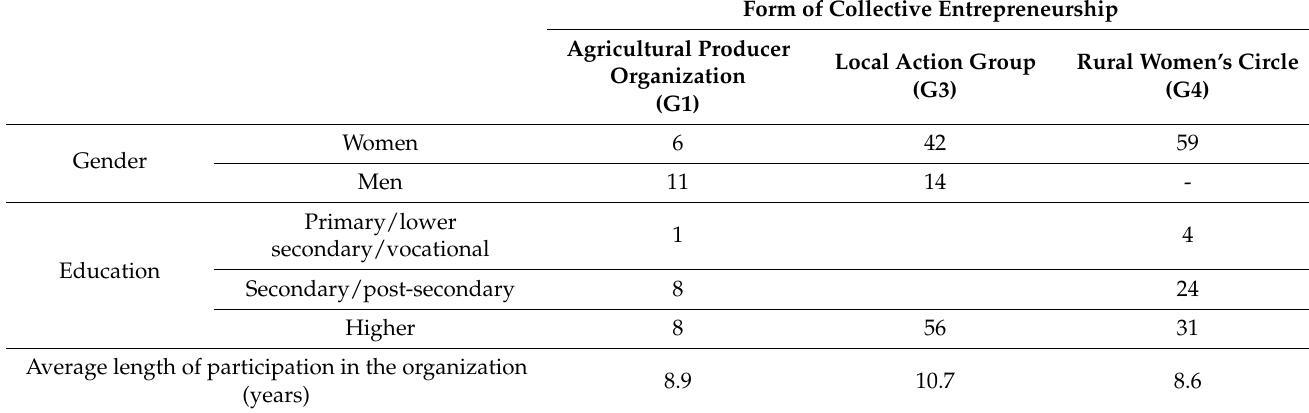
Table 1. Characteristics of the